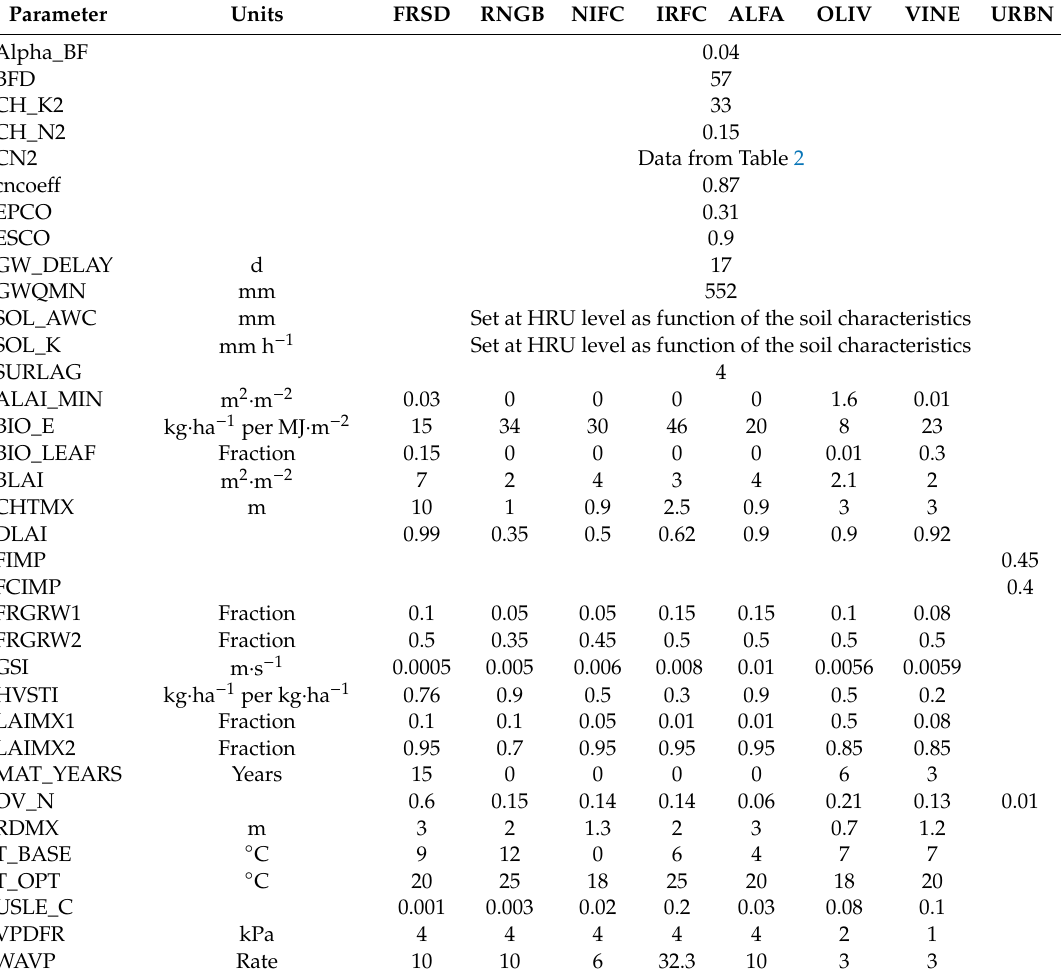
Table 3. Soil and Water Assessment Tool (SWAT) parameter values used for the simulation for each land cover. The land cover classes were as follows: meadow (ALFA); broad-leaved forest (FRSD); irrigated field crops (IRFC); unirrigated field crops (NIFC); olive groves (OLIV); transitional woodland-shrub-brush (RNGB); artificial surfaces (URBN); vineyards